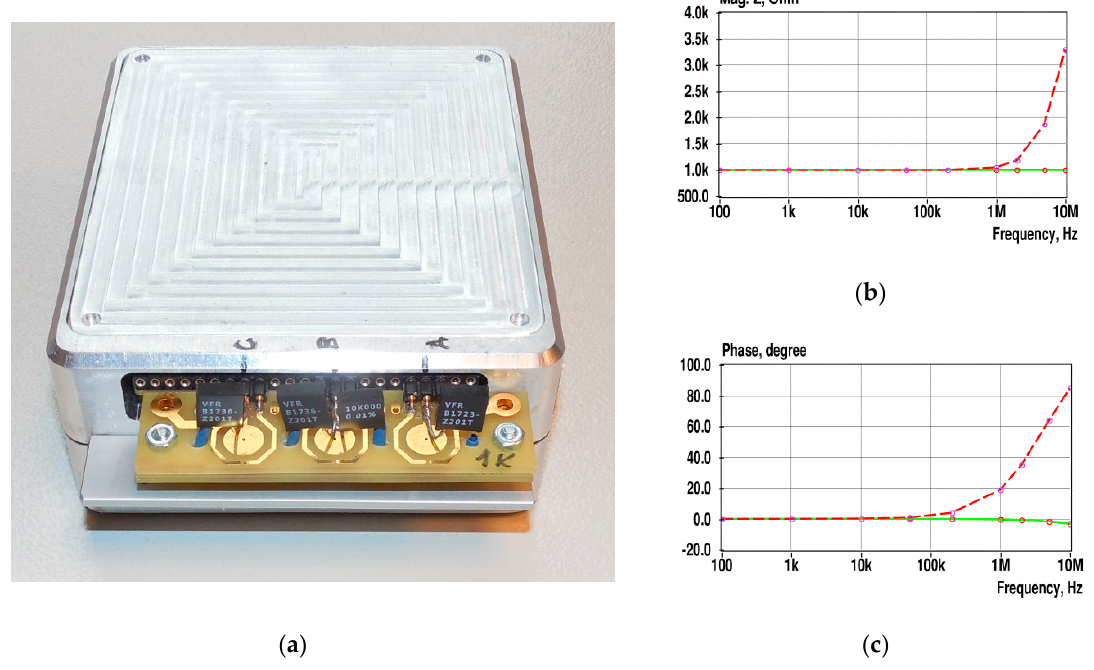
Figure 8. Precision resistors connected into a place of sensors for calibration ( a ), and the spectra ( b , c ) of the impedance of the 1 k Ω resistor connected to channel A before (dashed lines) and after usage of initial correction coefficients (solid lines). Ring-shaped marks indicate the used frequencies.